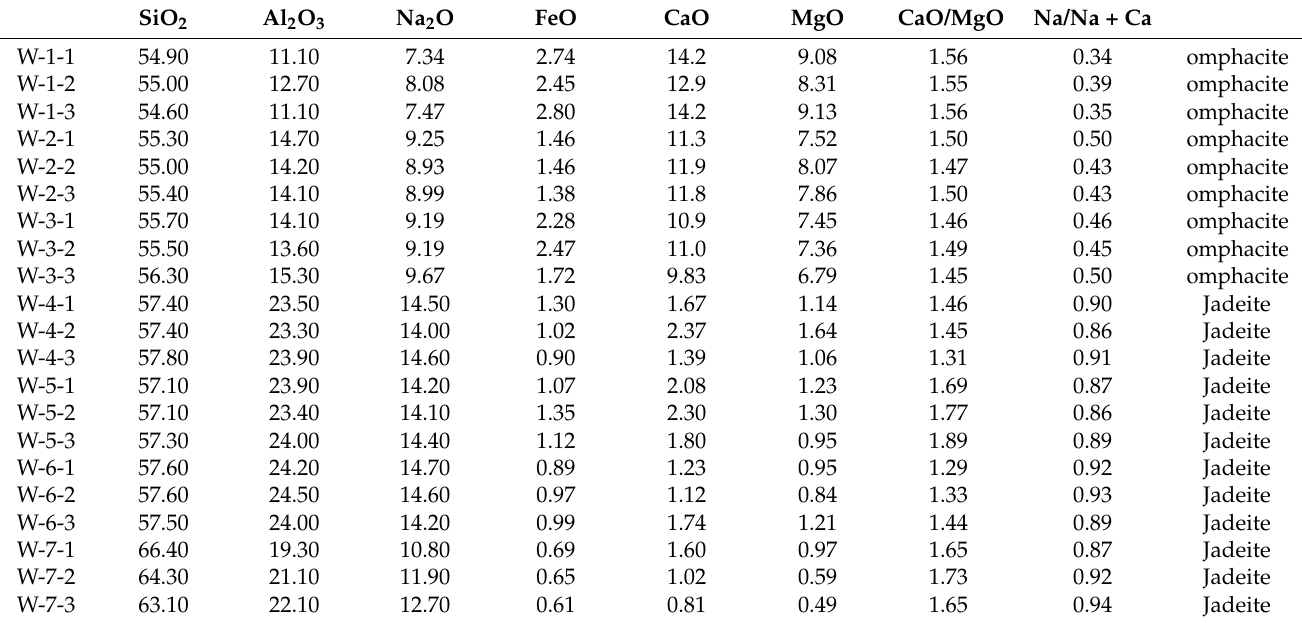
Table 1. Main chemical composition of Guatemalan jadeite